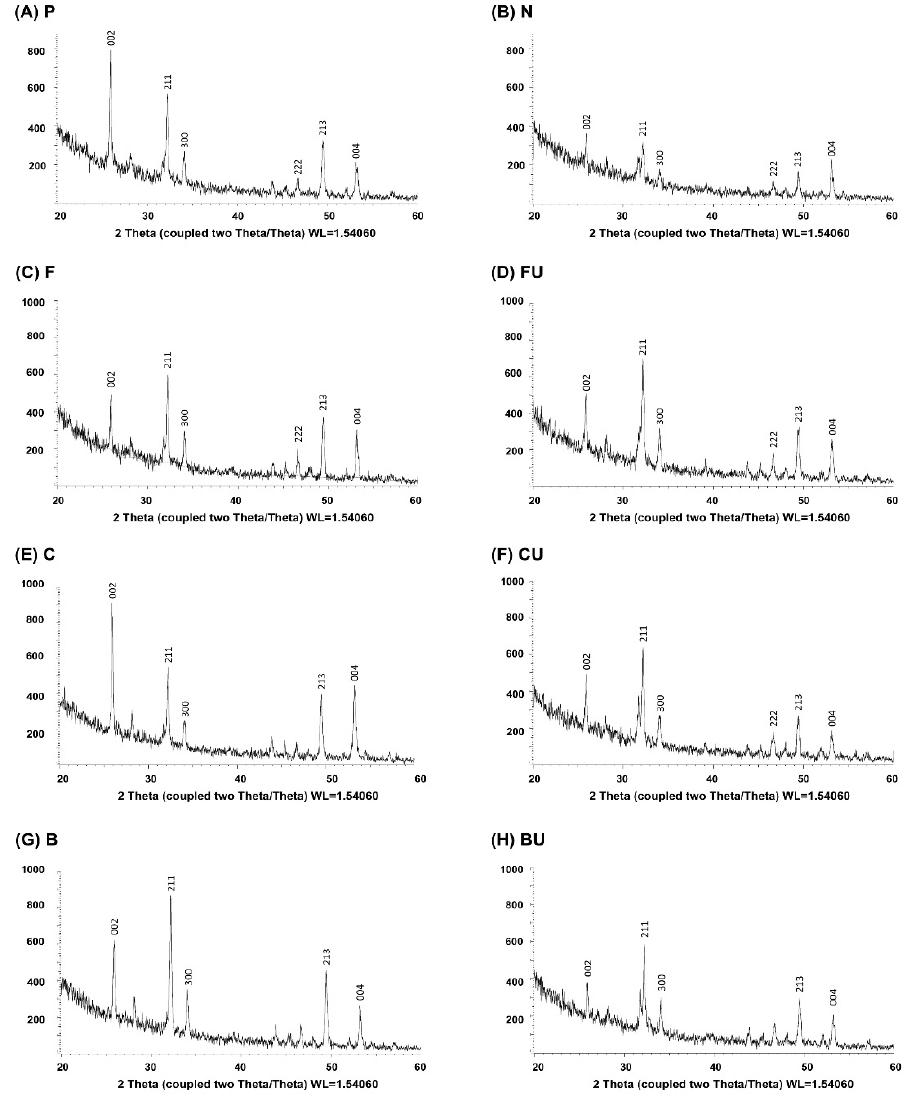
Figure 5. Results of XRD analysis. ( A ) Group P, ( B ) Group N, ( C ) Group F, ( D ) Group FU, ( E ) Group C, ( F ) Group CU, ( G ) Group B, ( H ) and Group BU. The decrease of HAP peaks [26° of (002) reflection and at 31.8° of (211) reflection] in Group N was obvious. It increased after the application of three varnishes with or without ultrasonication.